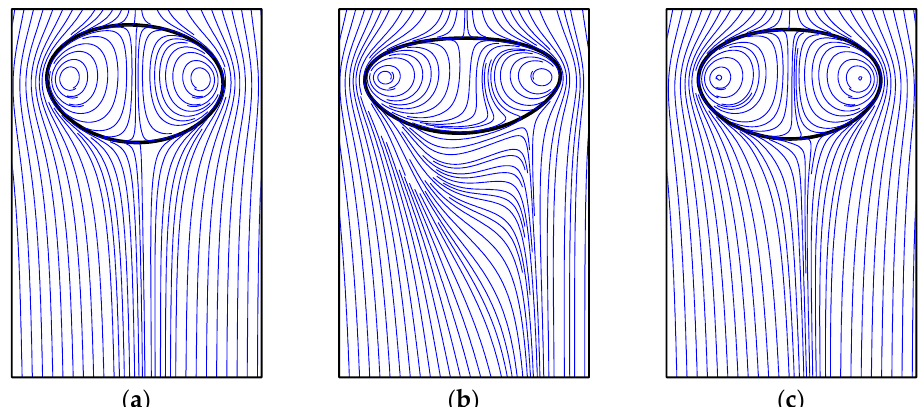
Figure 13. Streamlines ( u – U ) in x - z plane: right side is inside gap. ( a – c ) are under same conditions as in Figure 8. Flow direction behind bubble is from outside to inside.